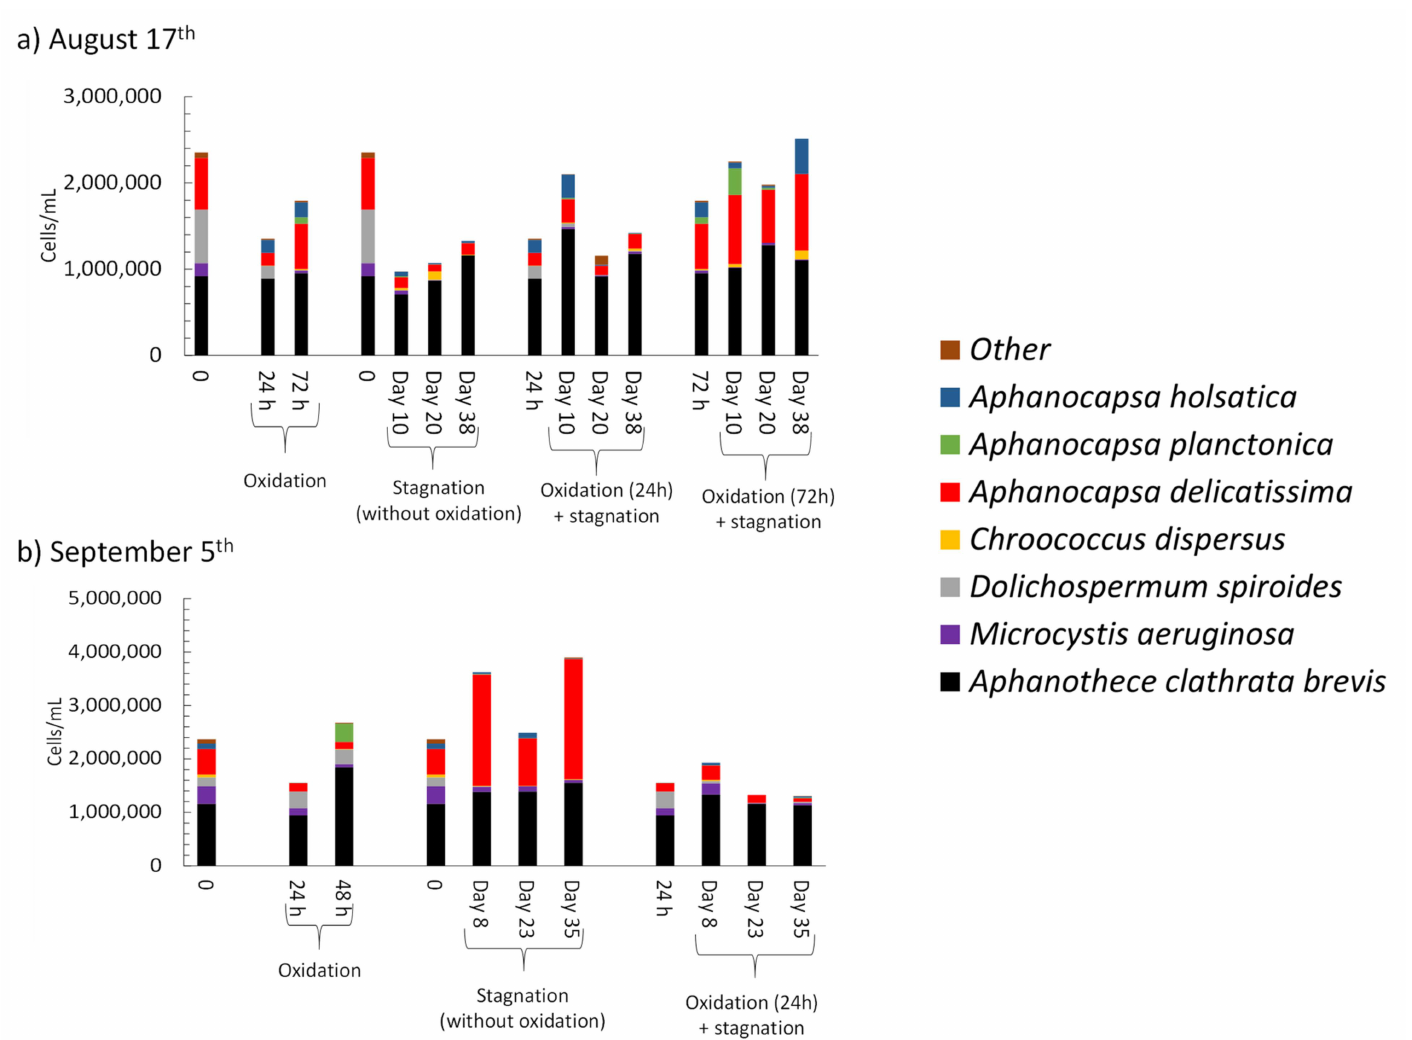
Figure 7. Taxonomic cell counts on ( a ) 17 August, and ( b ) 5 September after on-site oxidation using 10 mg/L KMnO 4 and stagnation. 0: Before oxidation, Day: Stagnation